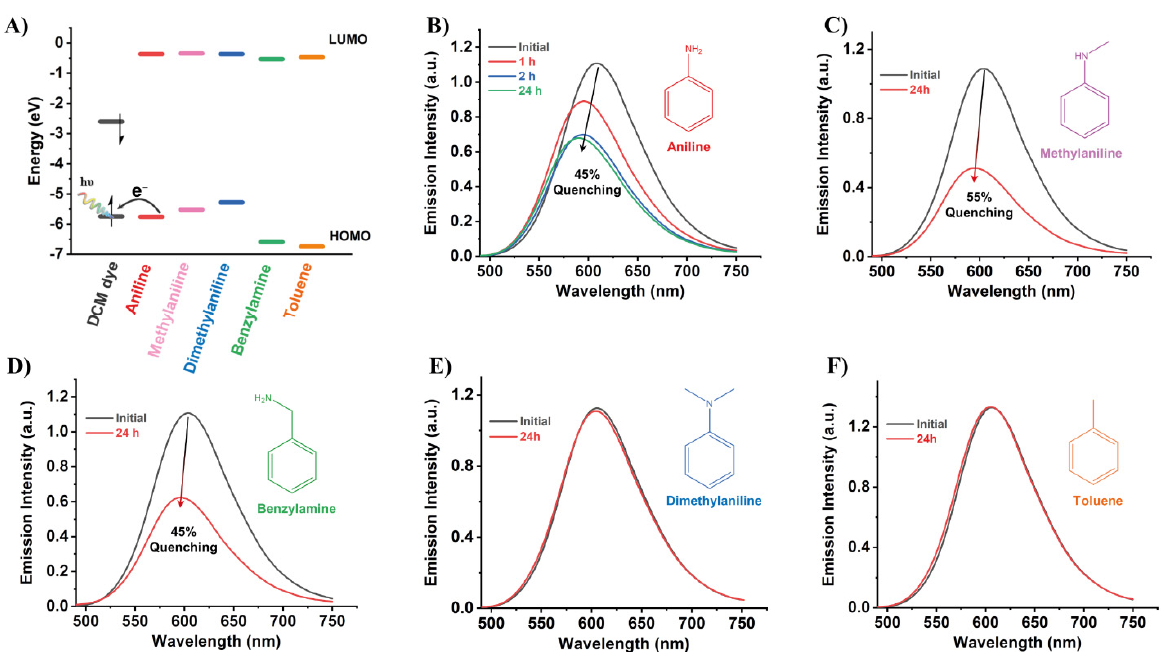
Figure 4. ( A ) Schematic representation of the HOMO-LUMO energy levels (in gas phase) for the DCM dye and the aromatic compounds used for the quenching test (aniline, methylaniline, dimethylaniline, benzylamine, and toluene). ( B – F ) Emission spectra of DCM/Al-ITQ-HB ([DCM] 0 = 1 × 10 − 4 M) in the absence and presence of aniline ( B ), methylaniline ( C ), benzylamine ( D ), dimethylaniline ( E ), and toluene ( F ) atmospheres. For ( B – D ) the percentage of emission quenching is displayed in the figure.